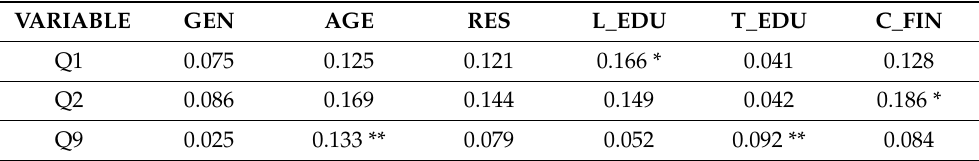
Table 3. Contingency coefficients (Pearson’s coefficient) for using environmental criteria in everyday life, awareness of SRI, and pro-ecological decisions vs. individual characteristics of respondents. VARIABLE